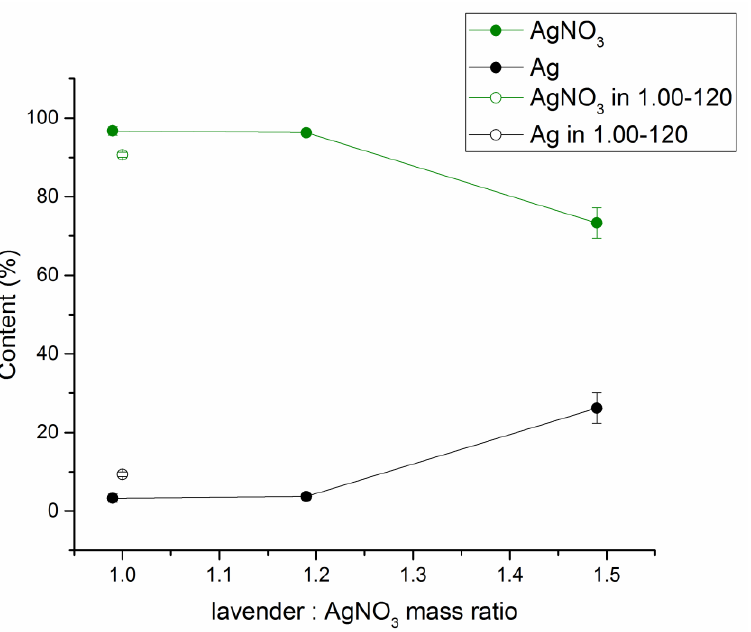
Figure 7. The content of Ag and AgNO 3 in the mechanochemically prepared samples with lowest lavender:AgNO 3 ratios.